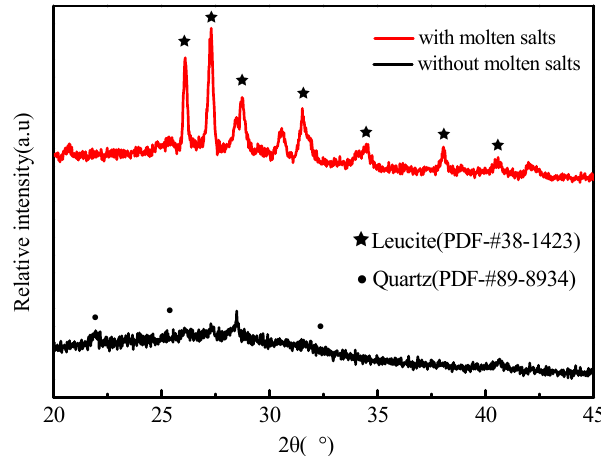
Figure 1. The XRD pattern of KGPs with and without molten salt.